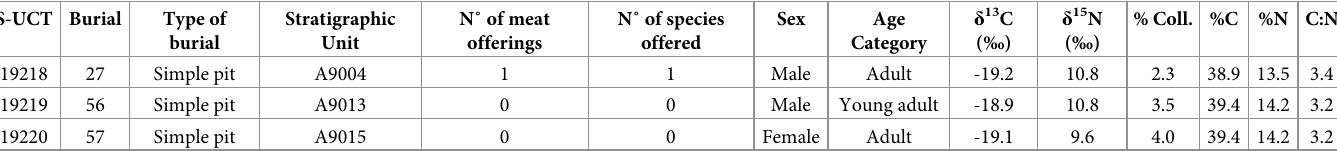
PLOS ONE | https://doi.org/10.1371/journal.pone.0271296 August 24,